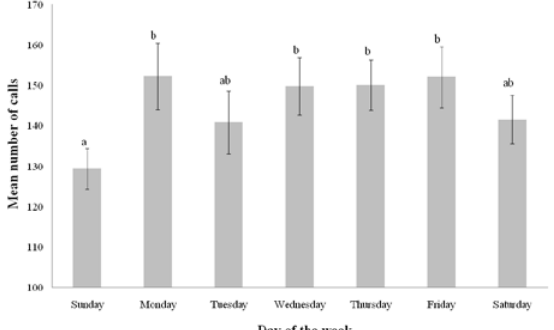
Figure 1. Mean number of Emergency Calls per day with standard error (light bars). Different letters indicate significant differences for p<0.05 evaluated by the LSD test.